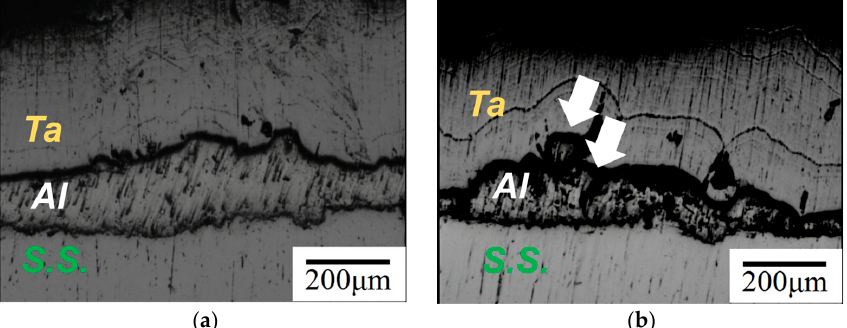
Figure 3. The surface characteristic of the multilayer structure of plasma-sprayed Ta–Al–SS: ( a ) Ta (400 μ m)/Al (100 μ m)/SS; ( b ) Ta (600 μ m)/Al (100 μ m)/SS.